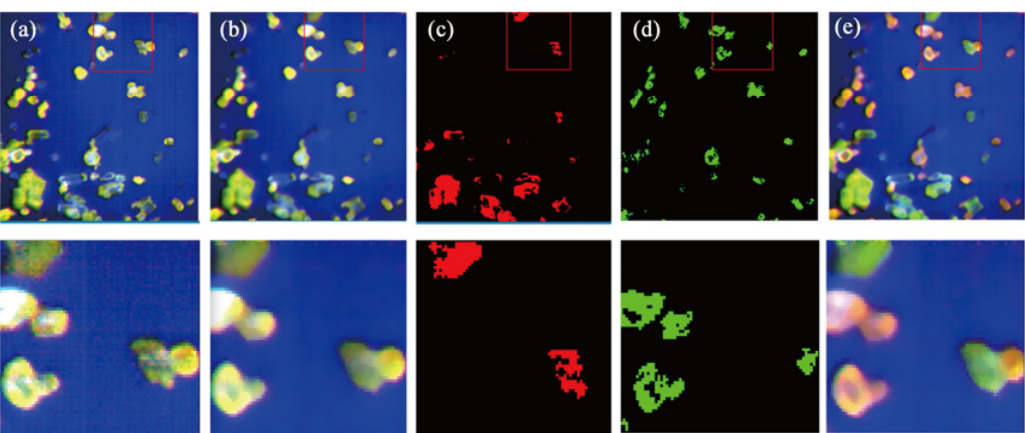
Fig. 9 (a) Raw data of mixed powders; (b) data after preprocessing; (c, d) results of classification; and (e) classified data in pseudo color.